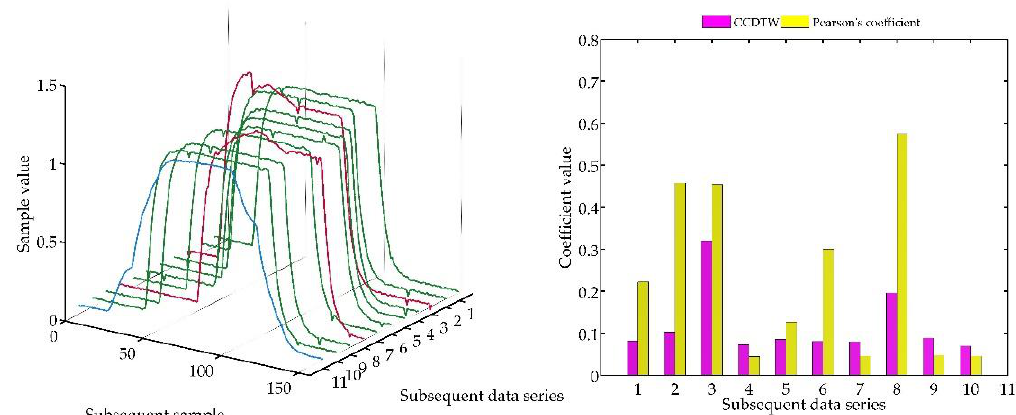
Figure 30. Simulation results based on measurement data for artificially disturbed, shifted charts № 3, № 8, and shifted non disturbed charts № 1, № 2, № 5, and № 6 for r ampl = 2.